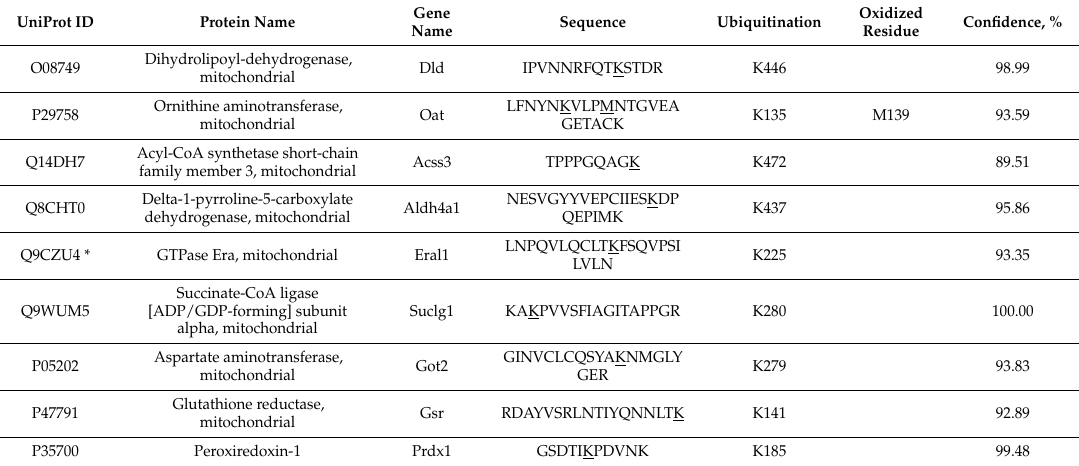
Table 2. Intrinsic brain mitochondrial proteins and their ubiquitination